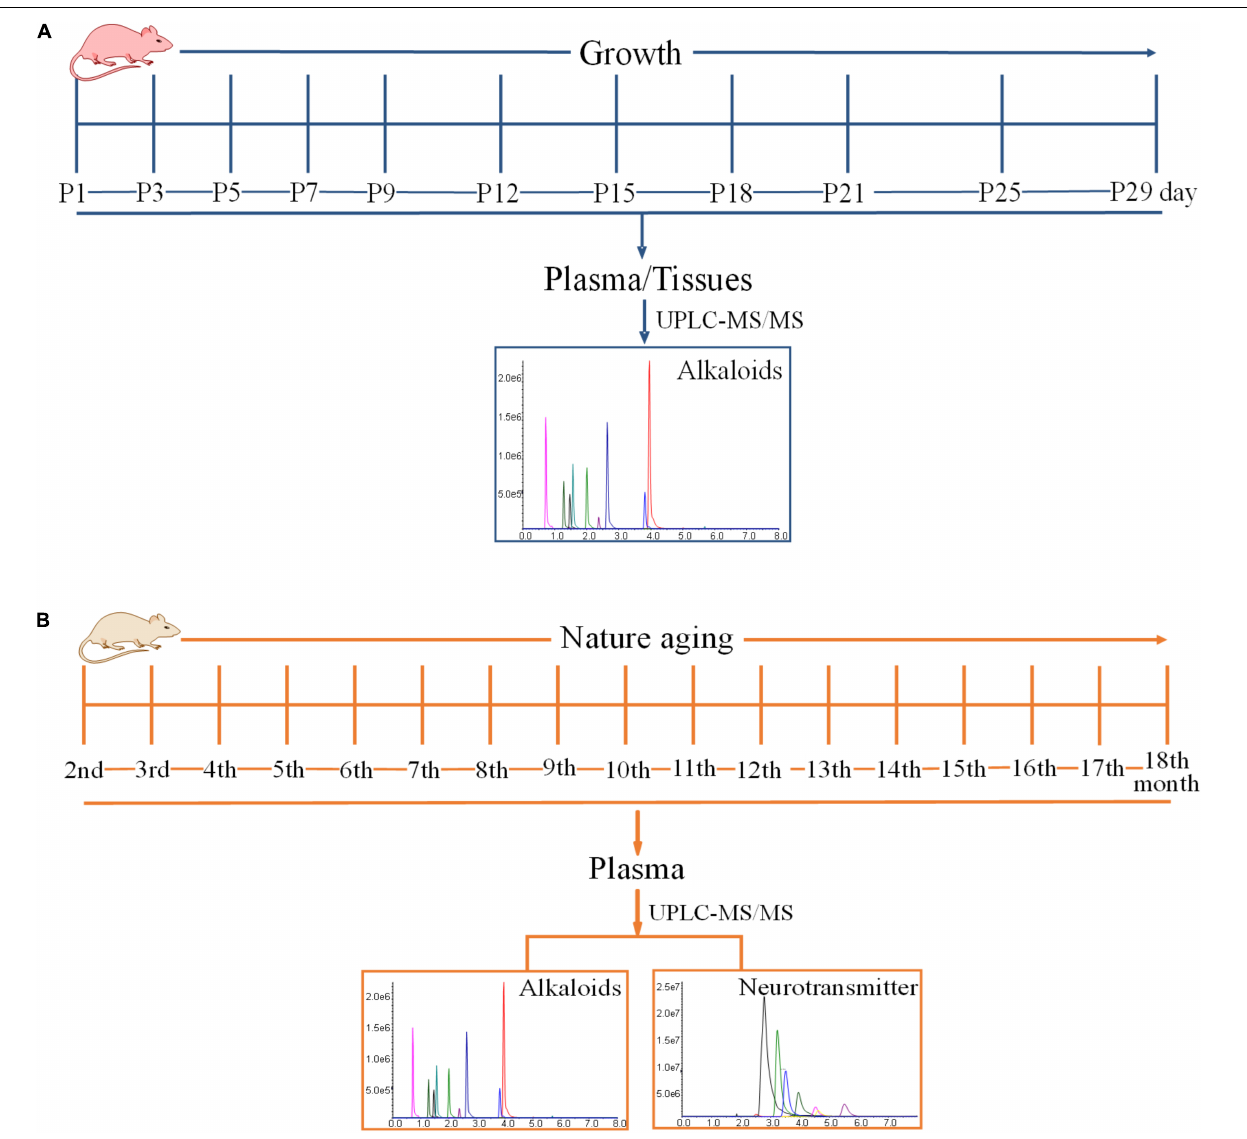
FIGURE 1 | Time schedules of experiment. (A) The time schedule of the experimentation on the exposure levels of alkaloids in the developmental phase of newborn rats within 29 days of birth. (B) The time schedule of the experimentation on the exposure levels of alkaloids and neurotransmitters during the growth of 18-month-old rats (from youth to old